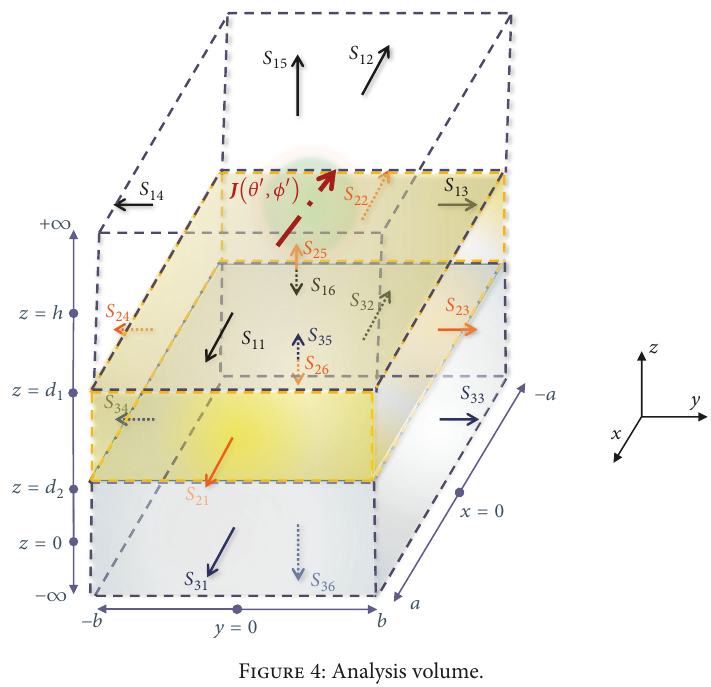
Figure 4: Analysis